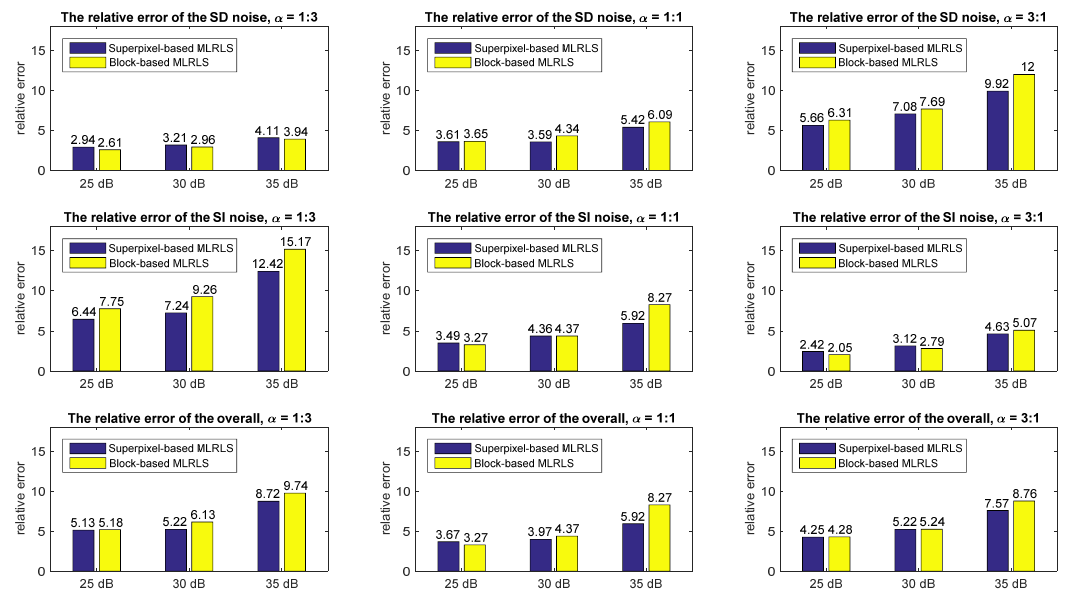
Figure 12. The optimal relative errors of the SD noise, the SI noise and the overall optimization for 1:4 spatial subsampling HSI.